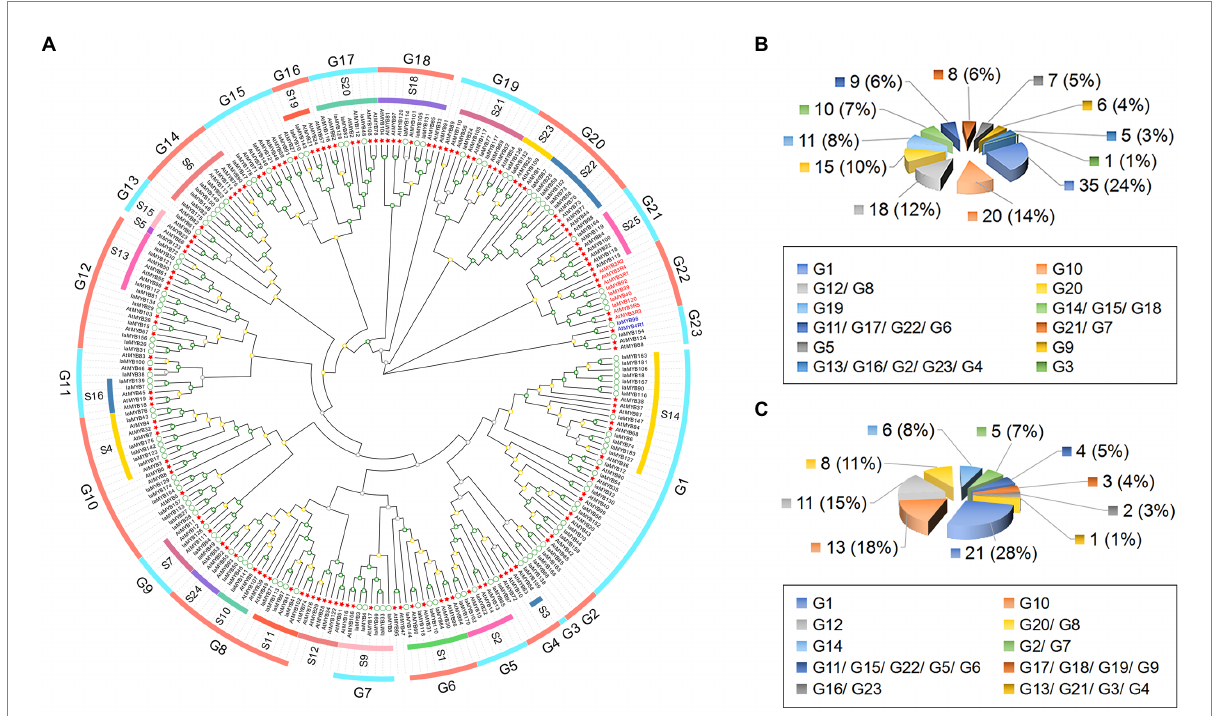
FIGURE 3 Phylogenetic relationships of MYB proteins in I. aquatica and A. thaliana . (A) The phylogenetic tree contains the 117 IaMYB proteins (including 112 2R-type IaMYB, 4 3R-type IaMYB, and one 4R-type IaMYB) and the 131 AtMYB proteins (including 125 2R-type AtMYB, five 3R-type AtMYBs, and one 4R-type AtMYB). (B) The number distribution of MYB proteins in each subgroup. (C) The number distribution of IaMYB proteins in each subgroup. The function of the AtMYB proteins in each subgroup were consistent with previous report in A. thaliana (Dubos et al., 2010). The green circles represent the IaMYB proteins. The red stars represent the AtMYB proteins. The red letters show the 3R-type MYB in I. aquatica and A. thaliana . The blue letters show the 4R-type MYB in I. aquatica and A. thaliana . The green, yellow and gray quadrangle represents the bootstrap value ranged from 80 to 100, 40 to 80, and 0 to 40,